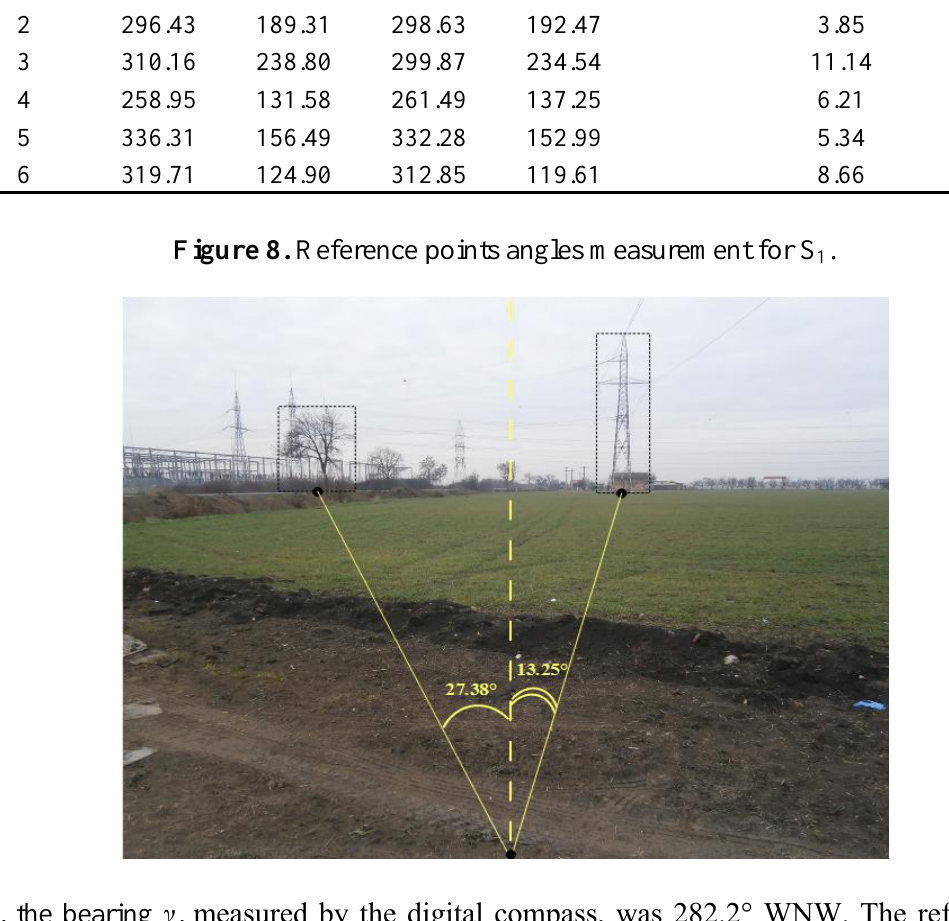
Table 1. Overall localization results for all six deployed nodes.